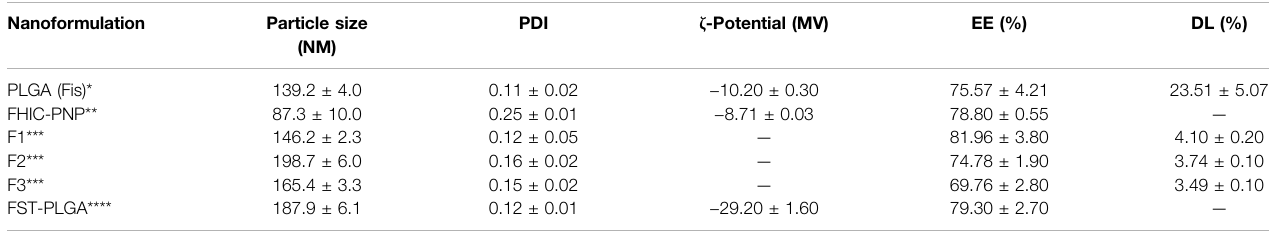
TABLE 1 | Particle size, polydispersity index (PDI), encapsulation ef fi ciency (EE), and drug loading (DL) data for present nanoparticles [PLGA (Fis)*] compared with those of Kadari et al ** Sechi et al *** and Liu et al **** . *Measurements were performed in triplicate. Nanoformulation